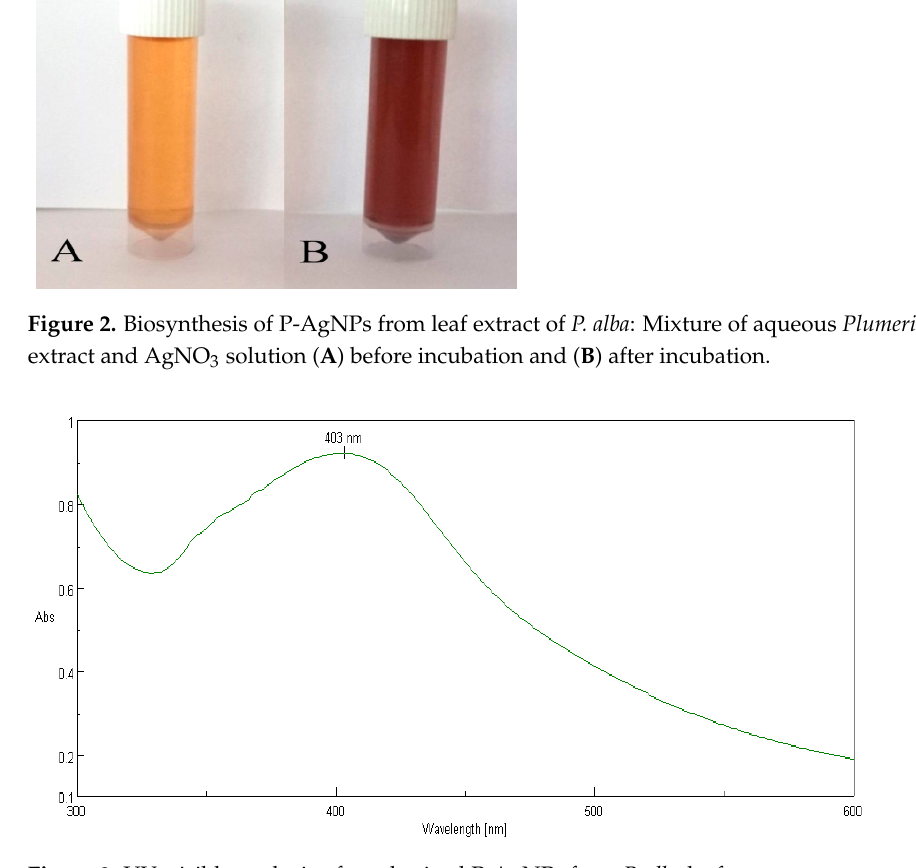
Figure 3. UV–visible analysis of synthesized P-AgNPs from P. alba leaf extract